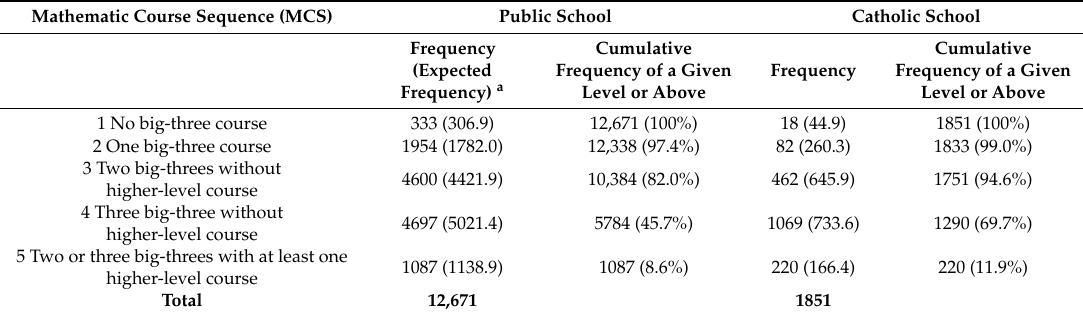
Table 7. Baseline di ff erence in Science Course Sequence (SCS) between di ff erent school sectors and Chi square test ( n =